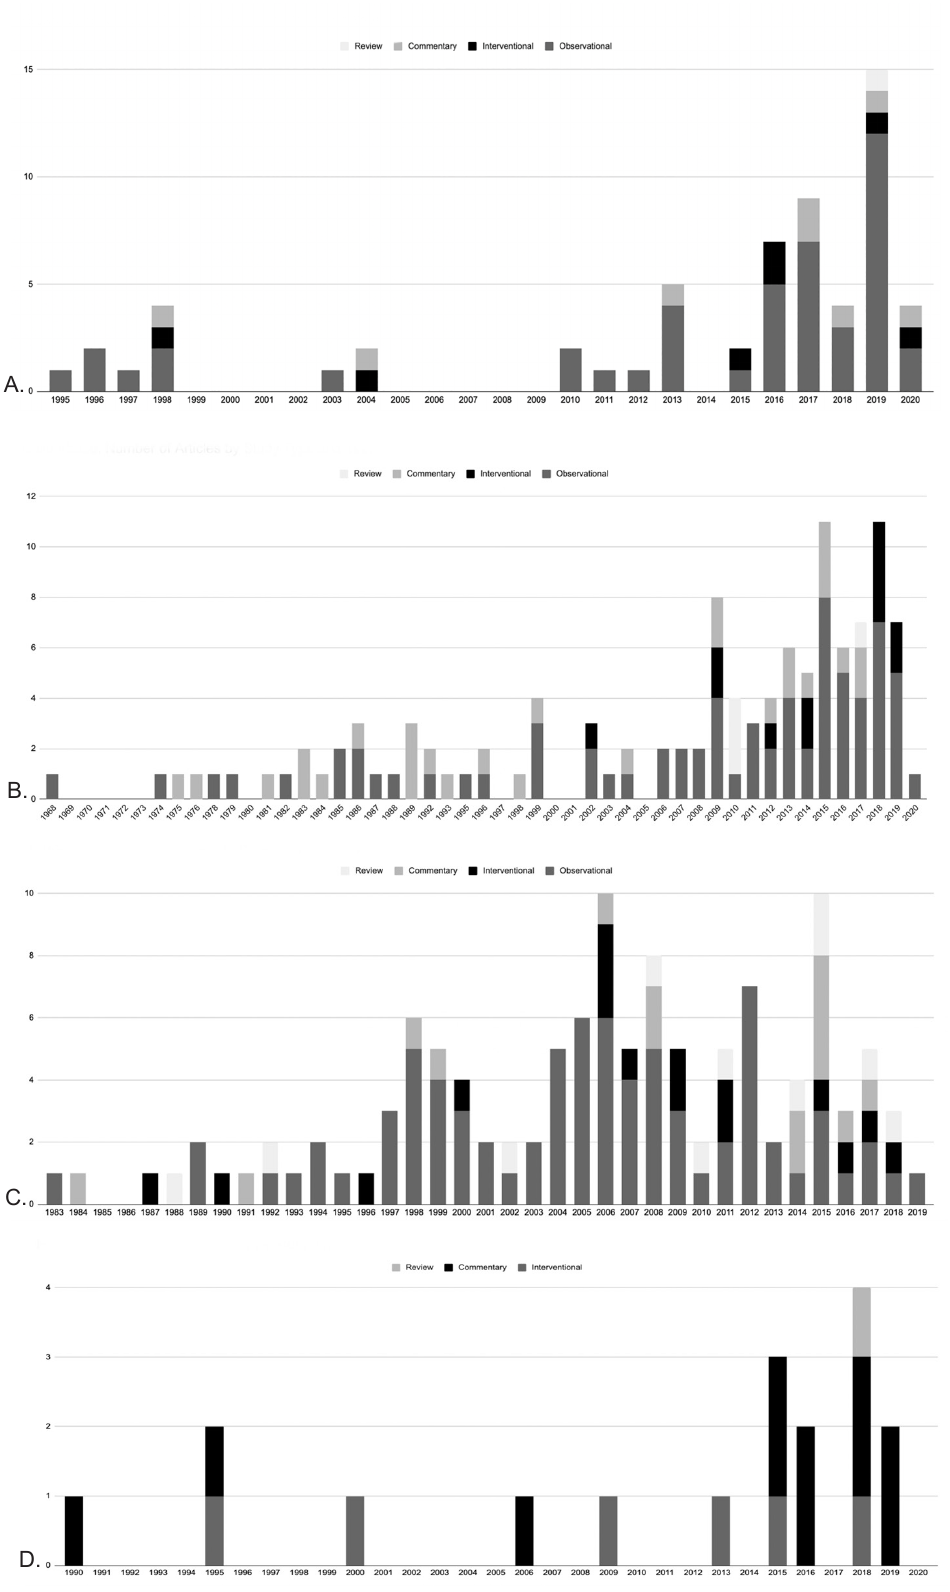
Figure 3A-D. Depiction of publication type and timeline of publications for A. firearm, B. child abuse, C. interpersonal violence, and D. homelessness topic areas in the social emergency medicine